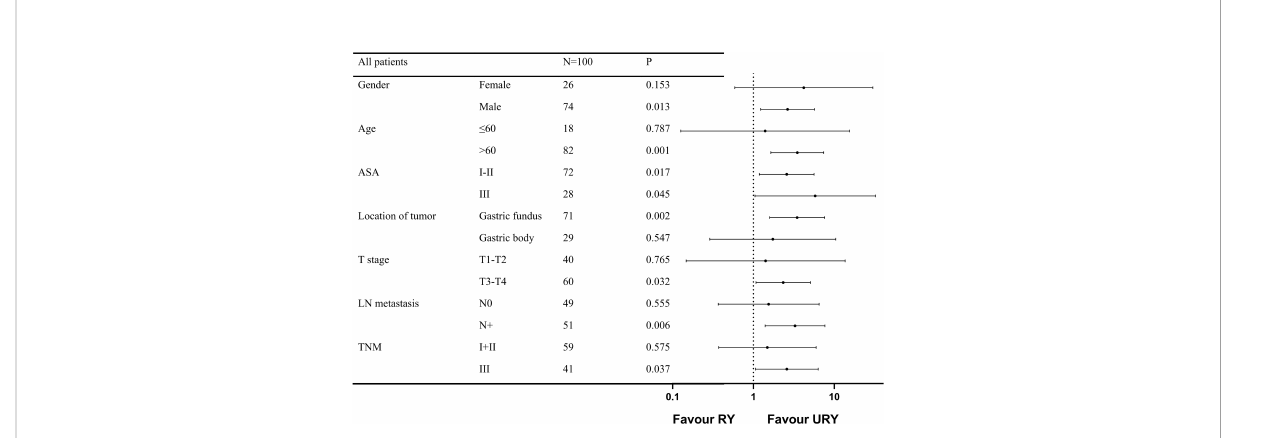
FIGURE 5 Forest plot evaluating the impact of TLTG with RY vs URY on PFS. TLTG: totally laparoscopic total gastrectomy; LN:Lymph node; RY: Roux-en- Y; URY: uncut